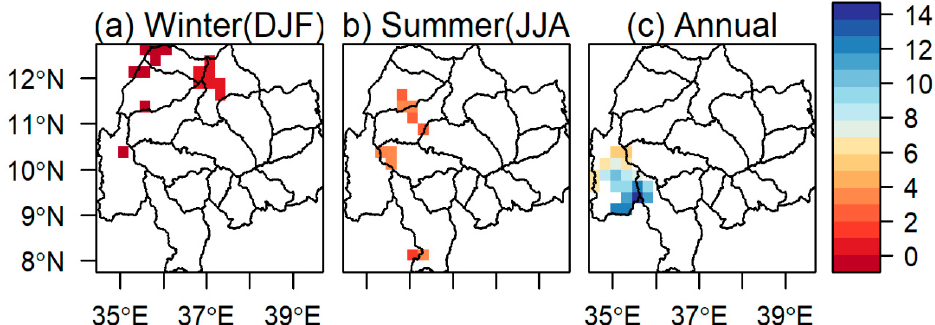
Figure 10. Zones with significant ( p < 0.05) increasing or decreasing trends for ( a ) winter, ( b ) summer, and ( c ) annually in the UBNB in Ethiopia for the period of 1992 to 2017. No significant trends were found over the spring and autumn seasons.